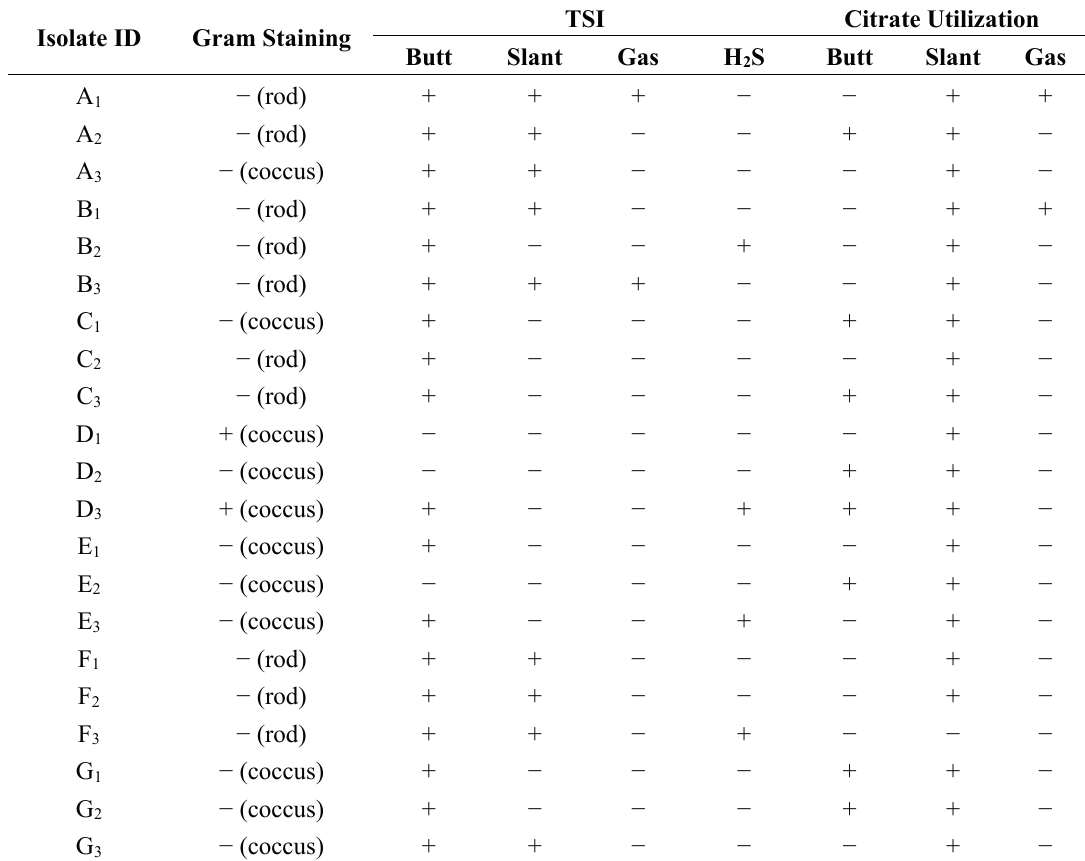
Table 3. Preliminary identification test results for presumptive coliform bacteria isolates with m-FC agar (+ = positive for the test; − = negative for the test). Isolate ID Gram Staining